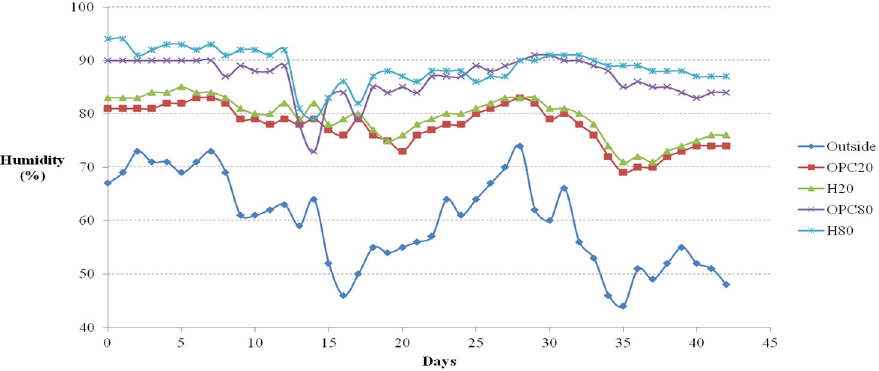
Figure 10. Relative humidity versus time curves.